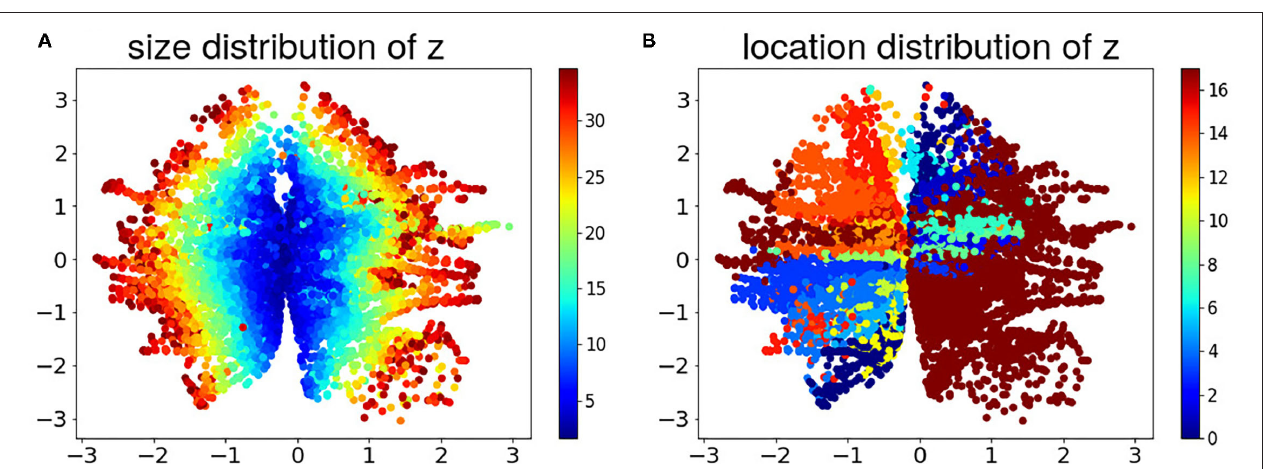
FIGURE 2 | Distribution of LD latent codes of the training data, color coded by (A) size of the abnormal tissue (the colors represent the percentage size of abnormal tissue). (B) Location of the abnormal tissue (the colors represent the 17 American Heart Association (AHA) segments of left ventricle).